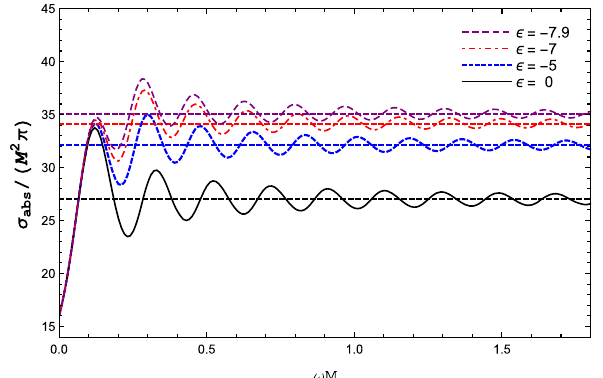
Fig. 13 Total absorption cross section of JPBHs for some non-positive values of ε . Although the first peak ( l = 0) does not change much, the second peak ( l = 1) increases significantly as we decrease the deformation parameter ε